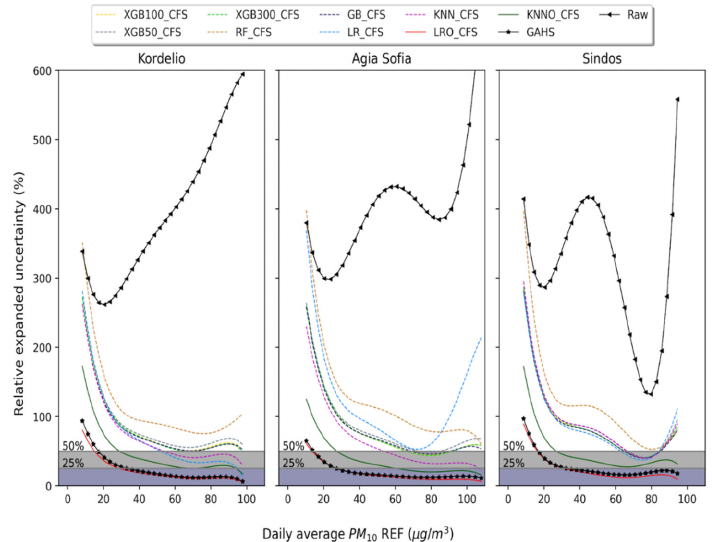
Figure 4. Model and sensor comparison against reference measurements in terms of REU for the ideal scenario. GAHS and LRO clearly outperform all other approaches reducing the uncertainty under 25% for particle concentrations ~25 μ g/m 3 and higher. The presented curves correspond to a fifth polynomial fit on the results.